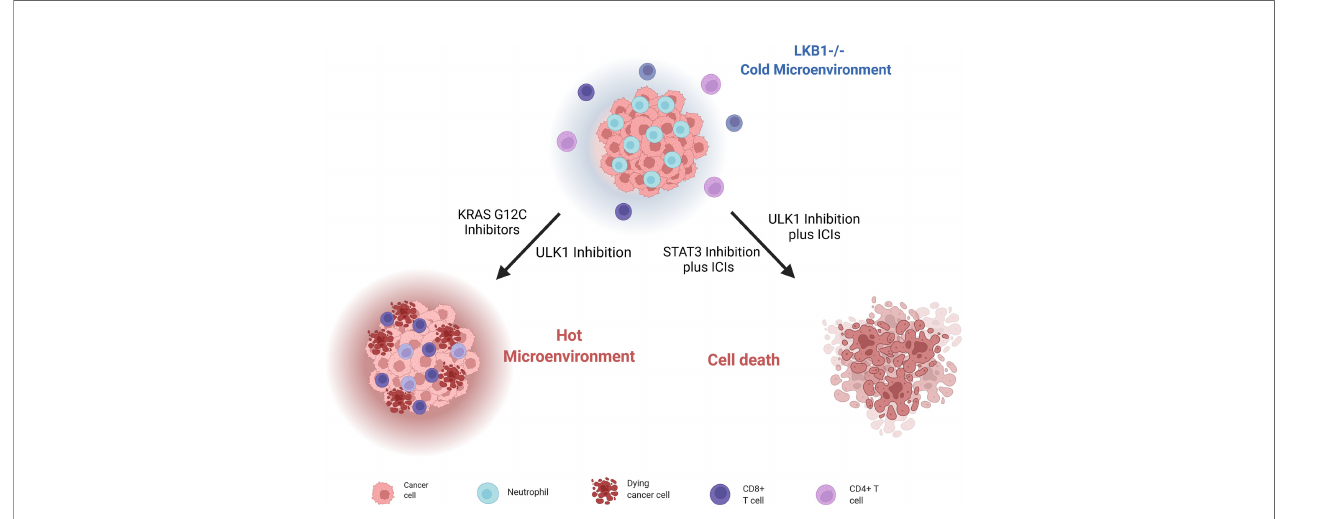
FIGURE 5 | Scheme of LKB1 -deleted cells immune microenvironment and different strategies to render them sensible to ICIs treatment and stimulate immune cells. Created with